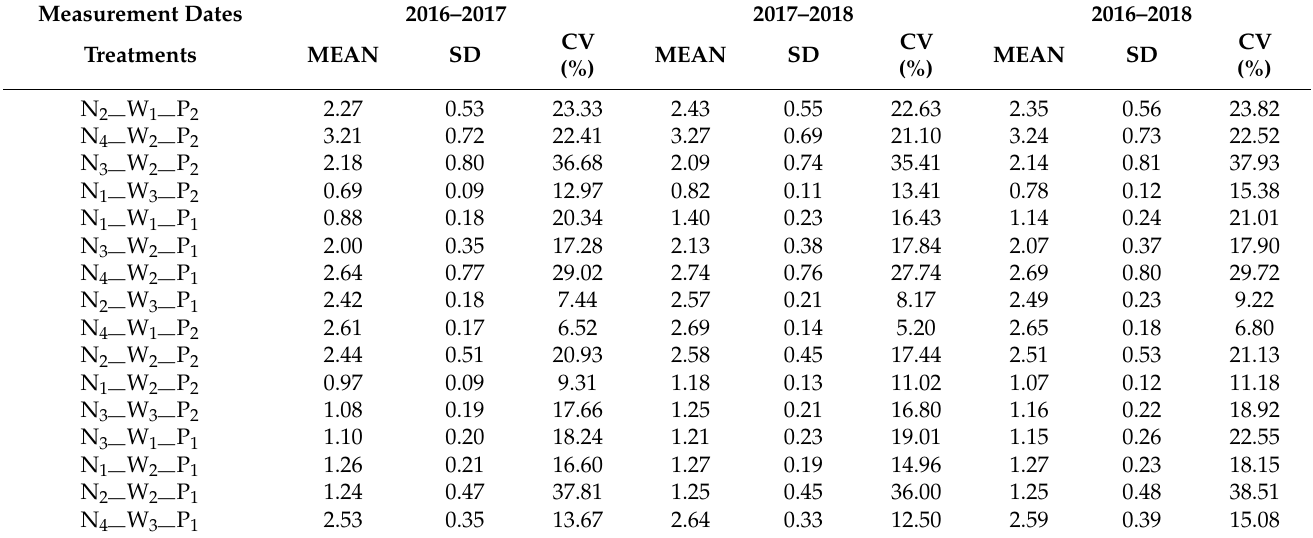
Table A6. Main statistical parameters of LAI at the grain filling stage under different treatments. Measurement Dates Treatments